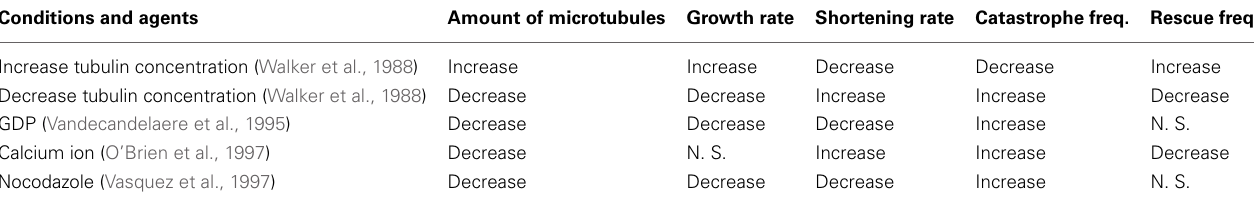
Table 1 | Effects of experimental conditions on microtubule dynamics. Conditions and